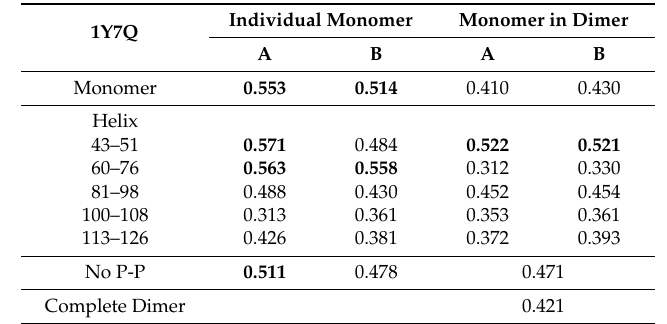
Table 3. RD coefficients describing the status of the hydrophobic core in the dimer and in each monomer of 1Y7Q. The table also lists the status (with respect to the monomer and the dimer) of individual helical folds. “No P-P” indicates parts of the monomers and the dimer following elimination of residues involved in protein-protein interactions.